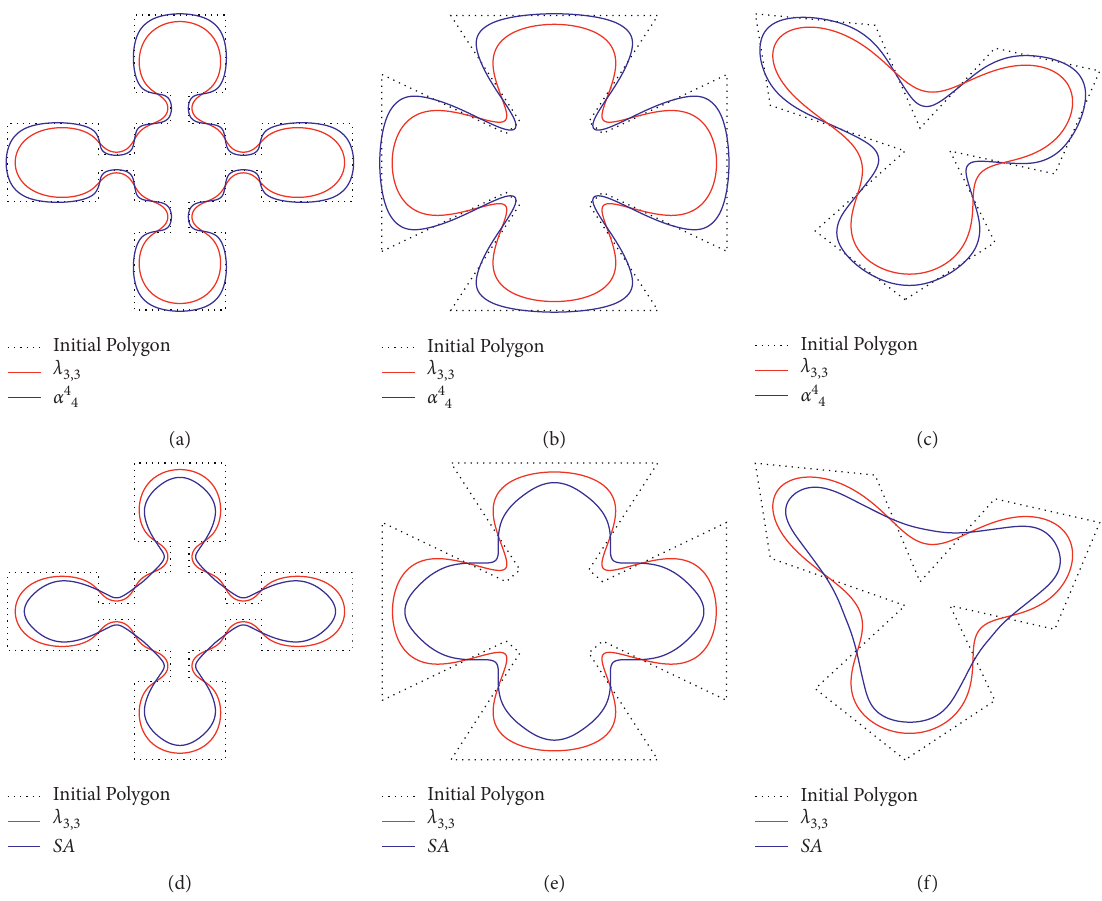
Figure 1: (a–c) Comparison of limit curves for close polygons produced by 4-point schemes λ